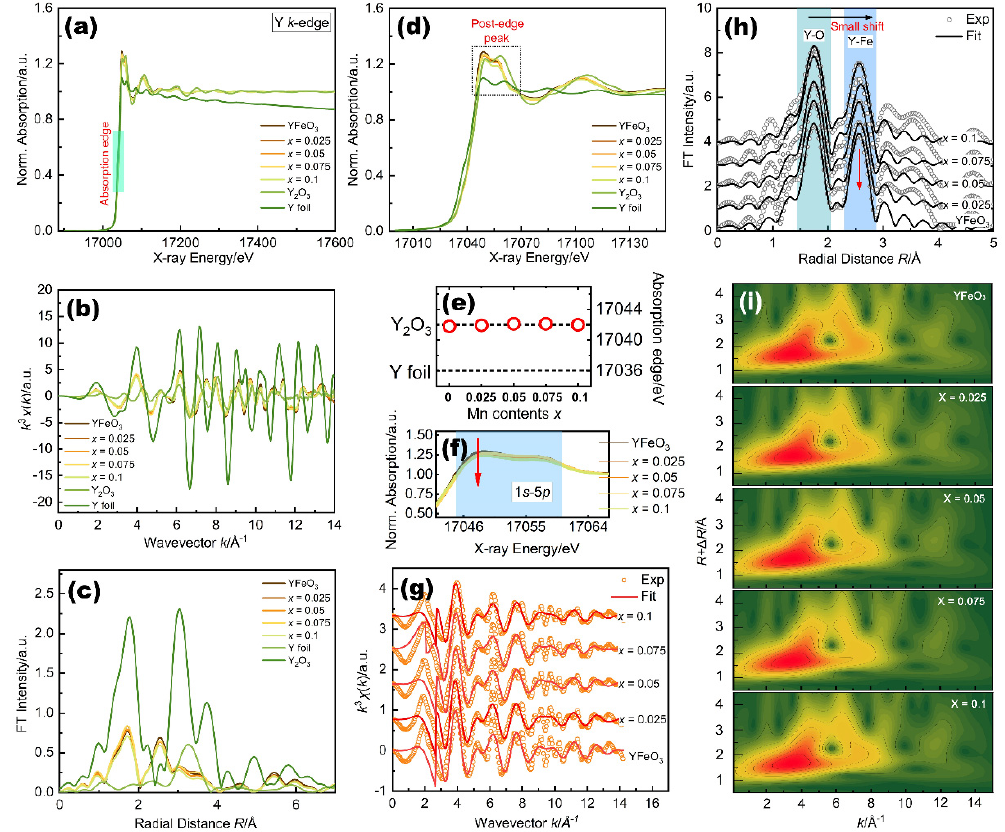
Figure 4. ( a ) Y K -edge XANES full spectra of YFM x O (0 ≤ x ≤ 0.1) and reference samples; ( b ) EXAFS oscillations of YFM x O and reference samples; ( c ) Fourier transform EXAFS functions of YFM x O and reference samples; ( d ) magnified XANES spectrum; ( e ) composition dependence of the absorption edge E o . The dashed lines represent E o of the reference samples; ( f ) enlarged XANES spectrum of the main peaks; ( g ) EXAFS spectra and best fits; ( h ) Fourier transform EXAFS data and best fits; ( i ) wavelet for the k 3 -weighted EXAFS signals; the data were offset for clarity.